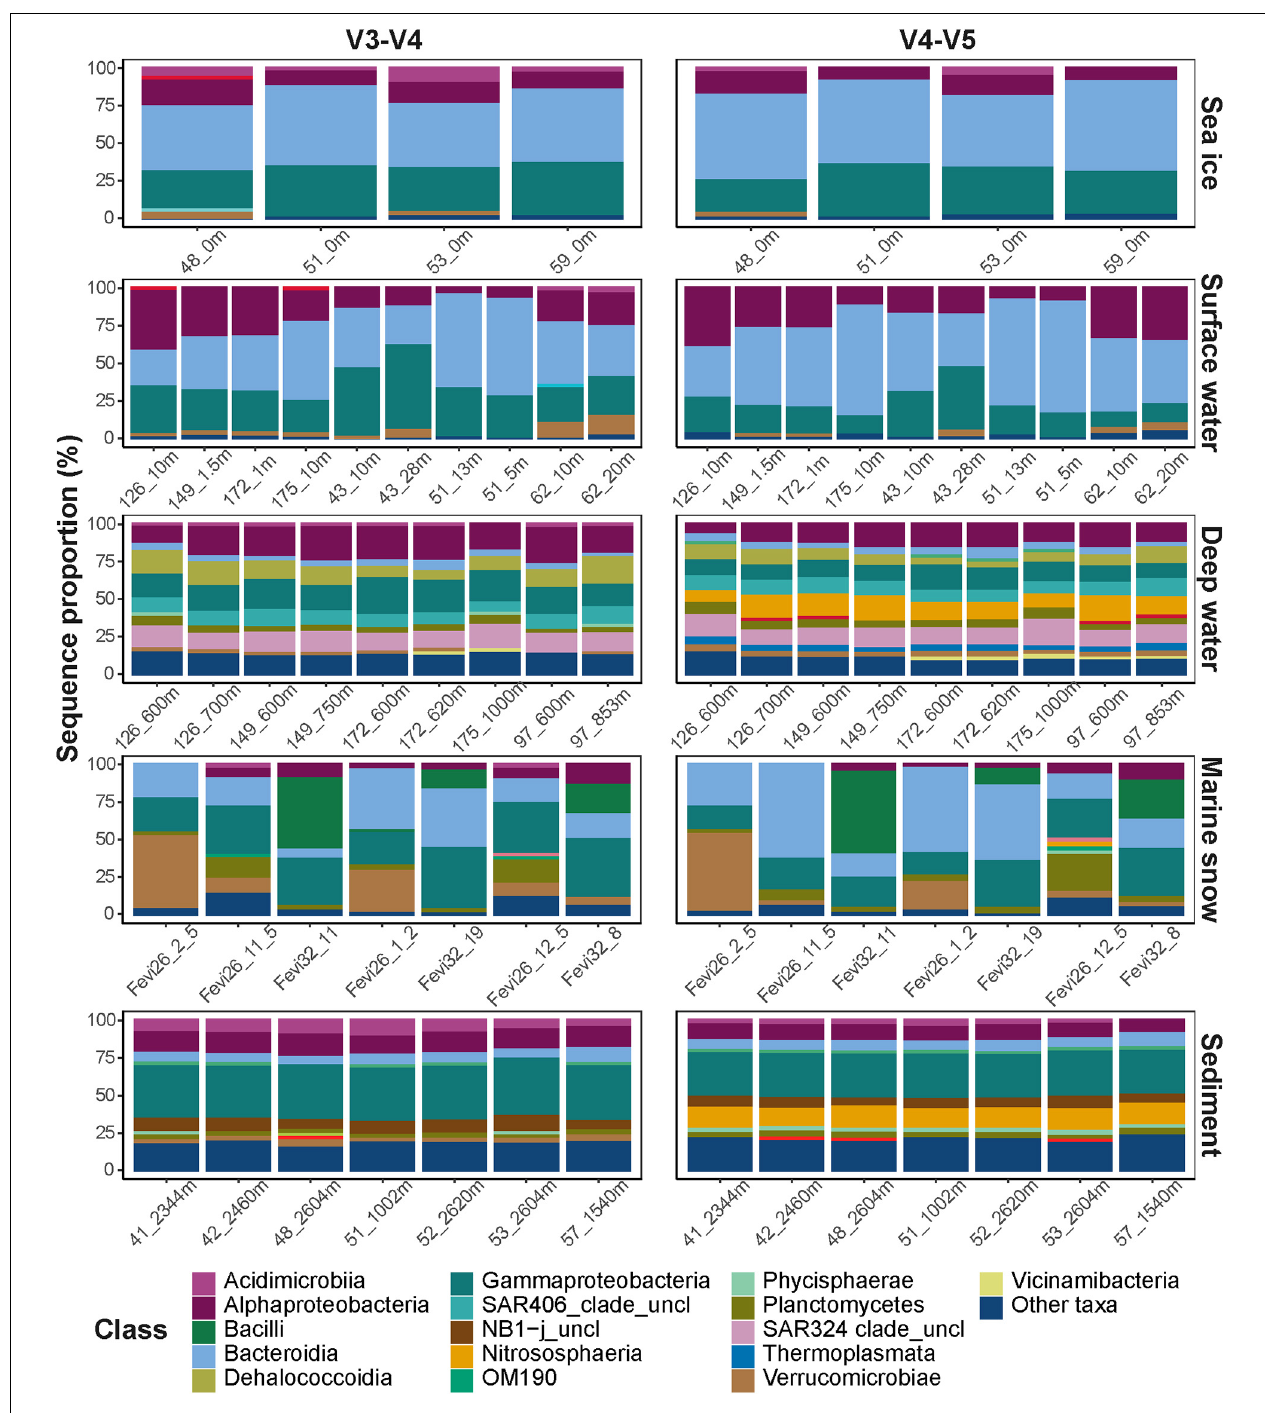
FIGURE 3 | Taxonomic compositions of the microbial communities. Different taxonomic classes are represented by color code. Classes with sequence proportion below 2% were classified as “Other